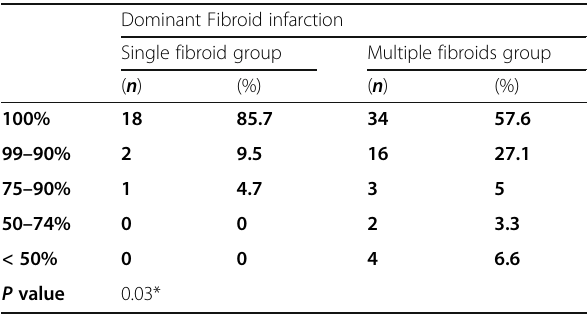
Table 3 Dominant fibroid volume reduction percentage